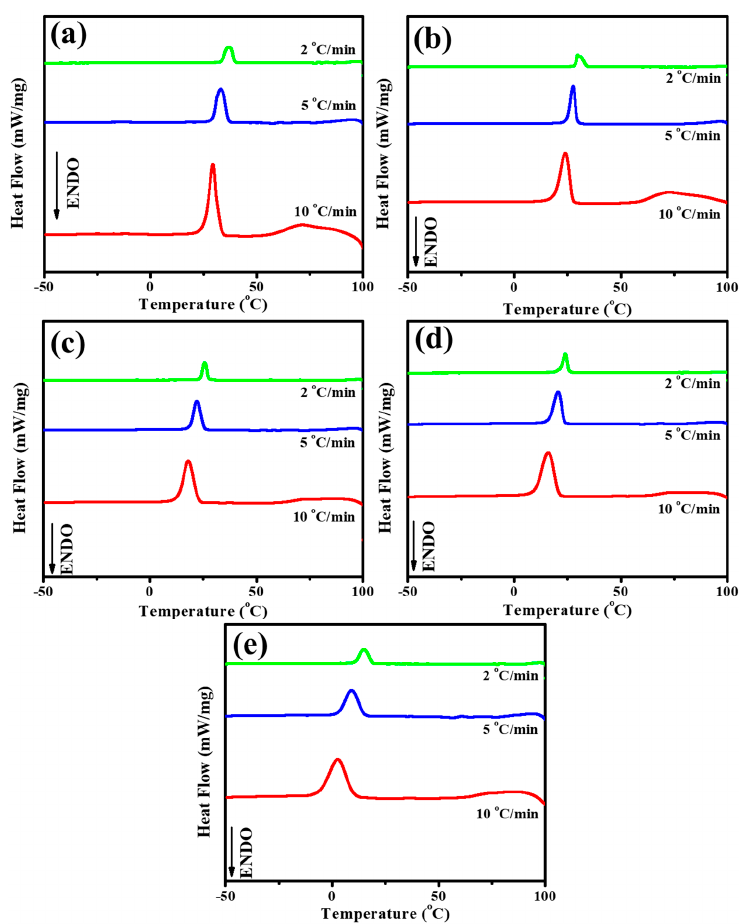
Figure 8. DSC curves of non-isothermal crystallization at different cooling rates and with a BA/BI content in ( a ) BA/BI = 100/0, ( b ) BA/BI = 95/5, ( c ) BA/BI = 90/10, ( d ) BA/BI = 85/15 and ( e ) BA/BI = 80/20.